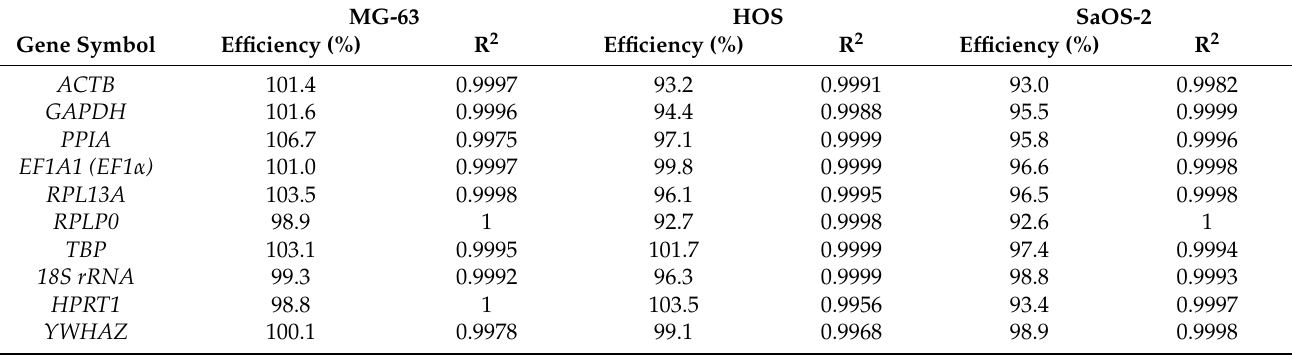
Table 2. Primer efficiencies and correlation coefficients (R 2 ) for selected internal control genes in MG-63, HOS, and SaOS-2 cell